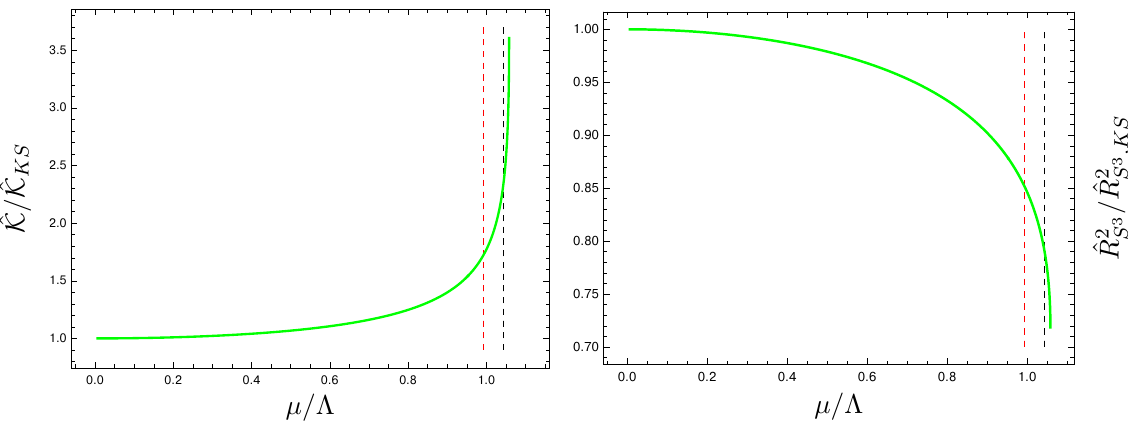
Figure 7 . Left panel: the reduced Kretschmann scalar ˆ of vacua in the deep IR of the bulk K V B denotes the value of the scalar for the Klebanov-Strassler solution, i.e., geometry, see (5.7). ˆ K KS when µ/ Λ = 0, see (5.8). Right panel: the rapid growth of the scalar when µ & µ χ SB (denoted by the vertical dashed black line) is caused by the collapsing 3-cycle of the conifold, see (5.9). ˆ R 2 S 3 ,KS denotes the size of this 3-cycle for the Klebanov-Strassler solution, i.e., when µ/ Λ = 0, see (5.10).